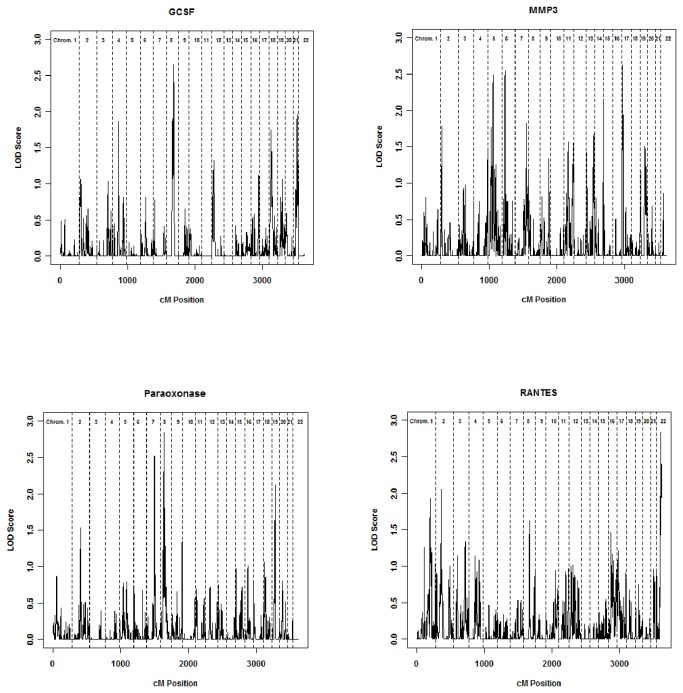
Multipoint genome-wide linkage scans for GCSF, MMP3, paraoxonase, and RANTES.Vertical dashed lines represent boundaries between chromosomal regions and the cumulative cM position is indicated on the X axis.